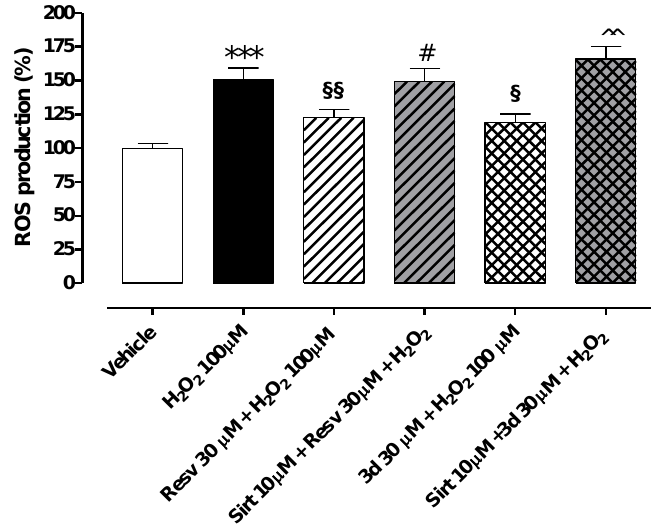
Figure 10. Preventive effects of resveratrol and compound 3d against H 2 O 2 -induced increase in intracellular ROS production: Potential role of sirtuins. Bars indicate intracellular ROS production (%) in HUVECs treated with H 2 O 2 100 µ M for 2 h. In the absence of the sirtuin inhibitor sirtinol (Sirt 10 µ M), both resveratrol (Resv) and 3d (30 µ M) incubated for 1 h significantly protected endothelial cells from the ROS increase. Conversely, in the presence of Sirt 10 µ M, the preventive effects of resveratrol and 3d against H 2 O 2 -induced increase in ROS were almost abolished. Data are shown as mean ± SEM. * indicates significant difference vs. vehicle (*** p < 0.001), § indicates significant difference vs. H 2 O 2 100 µM (§ p < 0.05; §§ p < 0.01), # indicates significant difference vs. Resv 30 µM + H 2 O 2 100 µM (# p < 0.05) while ^ indicates significant difference vs. 3d 30 µM + H 2 O 2 100 µM (^^ p <